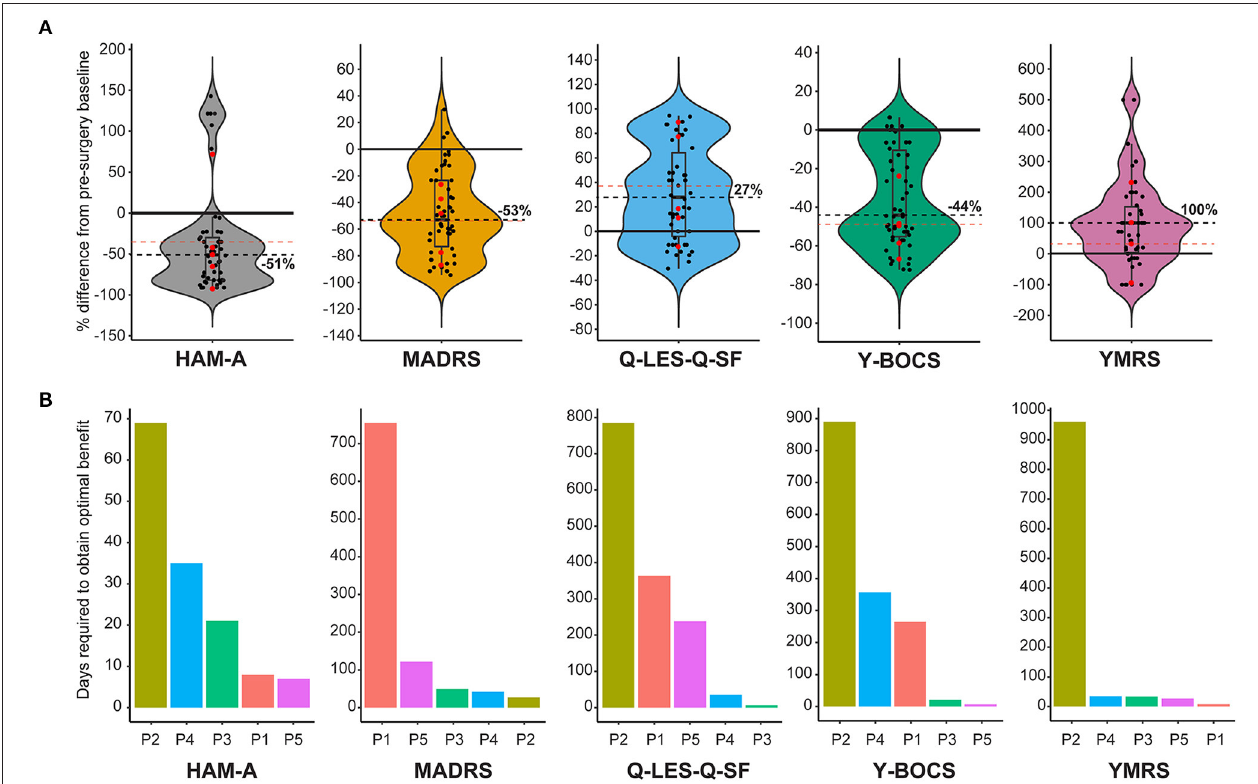
FIGURE 1 | (A) Violin plots showing group level representation of the percent change from pre-DBS surgery baseline across the five mood disorder scale metrics used for our cohort: Hamilton Anxiety Rating Scale (HAM-A), Montgomery-Åsberg Depression Rating Scale (MADRS), Quality of Life Enjoyment and Satisfaction Questionnaire (Q-LES-Q-SF), Yale-Brown Obsessive-Compulsive Scale (Y-BOCS), Young Mania Rating Scale (YMRS). Dots represent post-surgery DBS programming sessions. Each scale plot represents all subjects and all post-surgery DBS programming sessions for the first year of follow-up. The solid line demarcates no change (0%) on the y-axis, and the dotted line indicates the median percent change. Red points indicate percent change in scale metrics for each individual patient from the final follow-up and the red dotted line represents the mean for all patients for the final follow up. (B) Individual and scale differences in the number of programming sessions necessary to achieve optimal therapeutic stimulation. Each scale plot denotes the number of days required to achieve optimal stimulation for each patient highlighted by a different